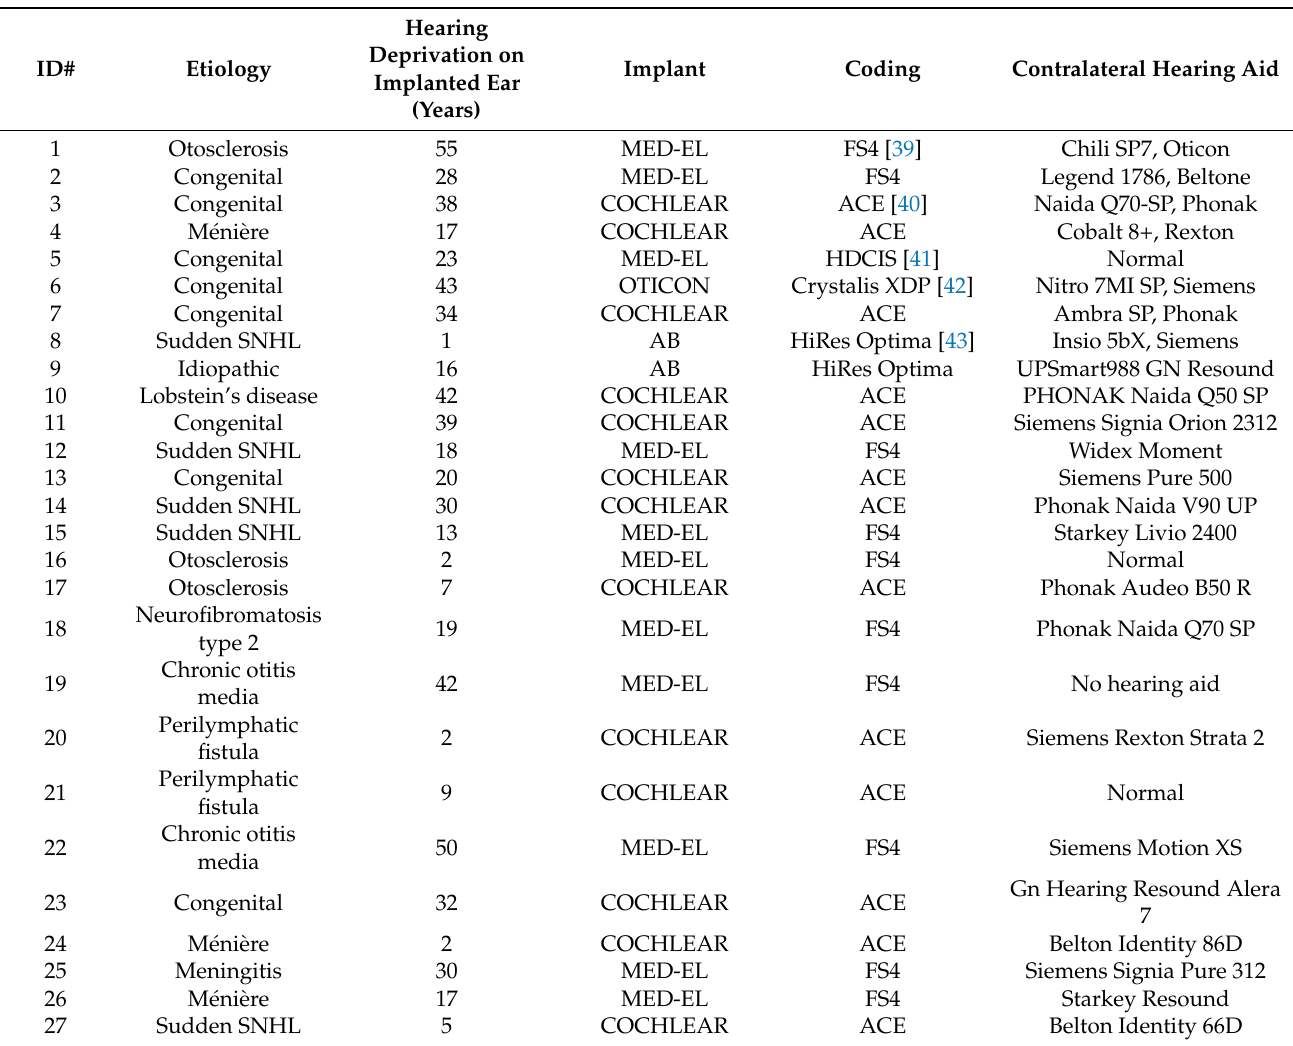
Table 1. Patient